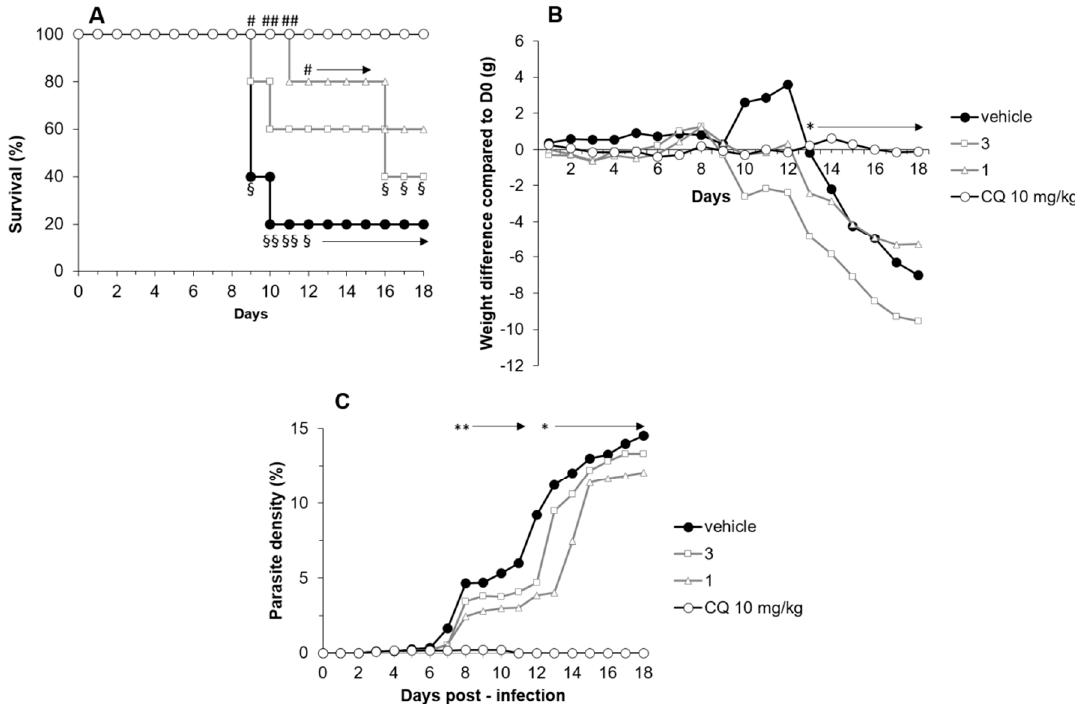
Figure 5. Effect of Compound 1 and 3 treatments on survival, parasitemia and weight of Plasmodium berghei ANKA-infected mice, compared to chloroquine and a vehicle. Mice ( n = 5 per group) were infected with 10 6 Pb A/mice at D0 before being daily treated intraperitoneally with Compounds 1 and 3 (both at 50 mg/kg), chloroquine (CQ, 10 mg/kg), or their vehicle (50% DMSO) during 4 days (D0 to D3). Mice were clinically monitored during 20 days. ( A ) Survival, ( B ) weight difference compared to D0 in g, and ( C ) parasite density (%). Groups were compared all together by a Kruskal–Wallis test (* p < 0.05, ** p < 0.005), or to CQ by a Bonferonni–Dunnett comparison (§§ p < 0.005, § p < 0.05), or to DMSO (## p < 0.005, # p < 0.05).